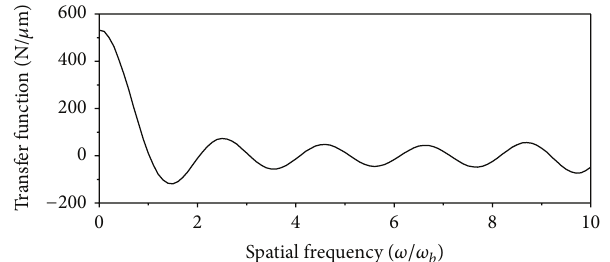
Figure7:Thetransferfunctionintheverticaldirectionasafunction of the spatial frequency.